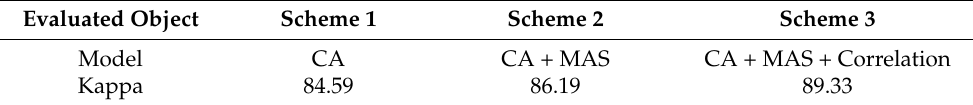
Table 4. Statistical precisions of PLES evolution prediction from three schemes Unit: %.